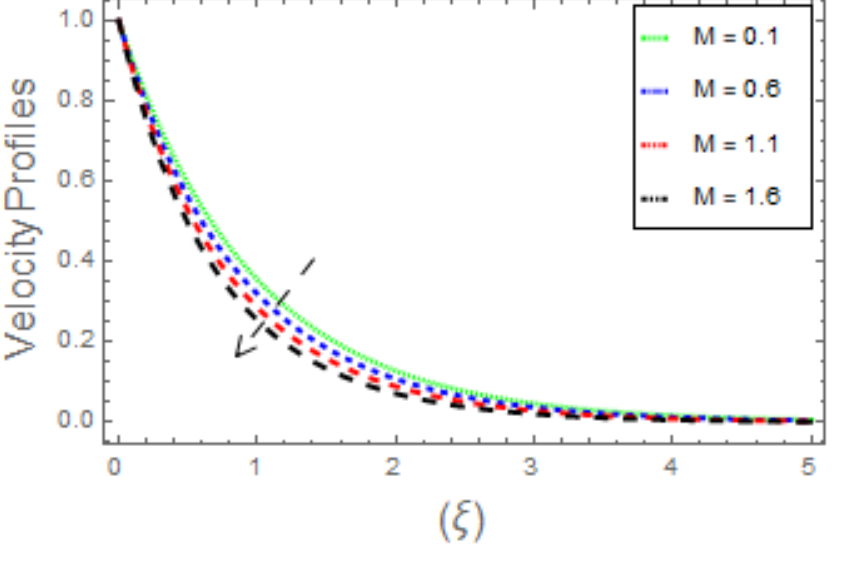
Figure 3. Variation in f (cid:48) ( ξ ) due to M